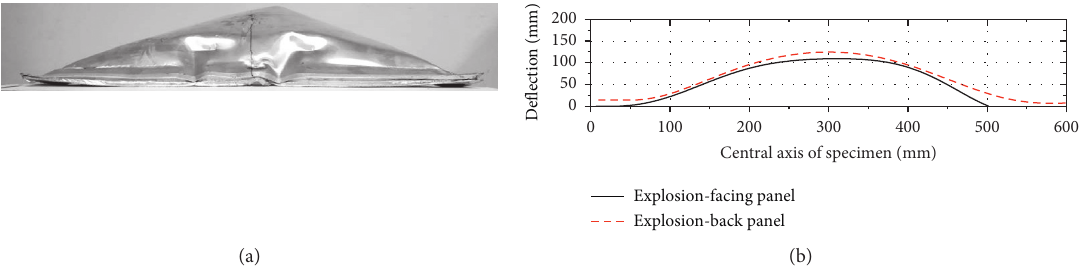
Figure 18: Side deformation and deflection of ST3. (a) Side view of ST3 deformation. (b) ST3 deflection data curve.